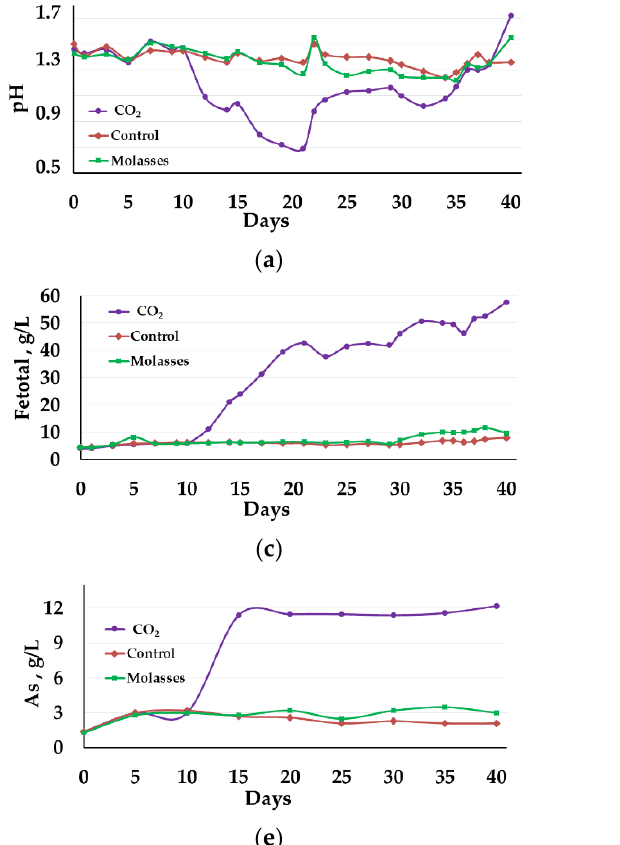
Figure 3. Changes in the liquid phase parameters during the bio-oxidation of the concentrate at 50 °C: ( a ) — pH; ( b ) — Eh; ( c ) — total concentration of Fe 3+ and Fe 2+ ions (g/L); ( d ) — concentration of Fe 2+ ions (g/L); ( e ) — concentration of arsenic (g/L).